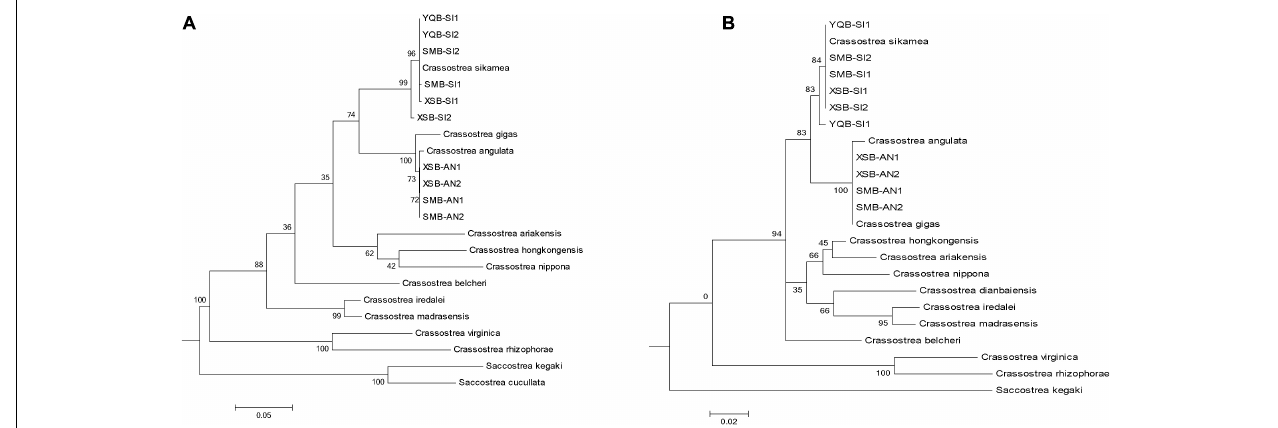
FIGURE 3 | The ITS1 and COI sequences of two identified individuals in each bay are randomly selected and the phylogenetic tree construction of representative oyster species in the database. Accession number of the reference sequences downloaded from NCBI database for (A) COI: Crassostrea_sikamea, EU007477 ; Crassostrea_angulata, LC383463 ; Crassostrea_gigas, MN862563 ; Crassostrea_hongkongensis, KP734091 ; Crassostrea_ariakensis, KF272859 ; Crassostrea_nippona, FJ743531 ; Crassostrea_belcheri, JF915511 ; Crassostrea_iredalei, JF915503 ; Crassostrea_madrasensis, JF915507 ; Crassostrea_virginica, KU905908 ; Crassostrea_rhizophorae, HM003498; Saccostrea_kegaki, LC110472. (B) ITS1: Crassostrea sikamea, FJ222345 ; Crassostrea hongkongensis, FJ222331 ;Crassostrea gigas, KM460835 ; Crassostrea ariakensis, EU252081 ;Crassostrea angulata, KU726937 ;Crassostrea nippona, FJ356679 ;Crassostrea belcheri, EU073256 ;Crassostrea iredalei, FJ222362 ;Crassostrea madrasensis, EU073237 ;Crassostrea dianbaiensis, AB972050 ;Crassostrea virginica, EU073344 ;Crassostrea rhizophorae,KF370460;Saccostrea kegaki, LC111294. TABLE 3 | Production performance and mantle edge pigmentation distribution of one-year-old oysters of Kumamoto oyster and Portuguese oyster. Shell height (mm) Shell length Shell width Total weight (g) SH:SL SH: SW Margin-yellow Margin-black